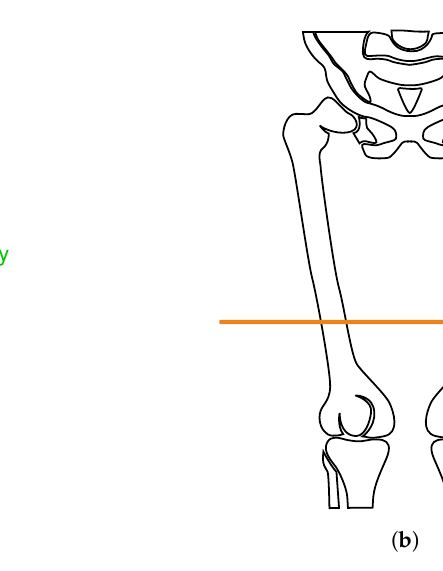
Figure 1. This figure shows the two sensor positions (highlighted with orange lines) used for our dataset. ( a ) The lower back sensor is positioned at approximately the 3rd lumbar vertebra. The z-axis of the coordinate system points forward. ( b ) The thigh sensor is positioned approximately 10 cm above the upper kneecap. The z-axis points